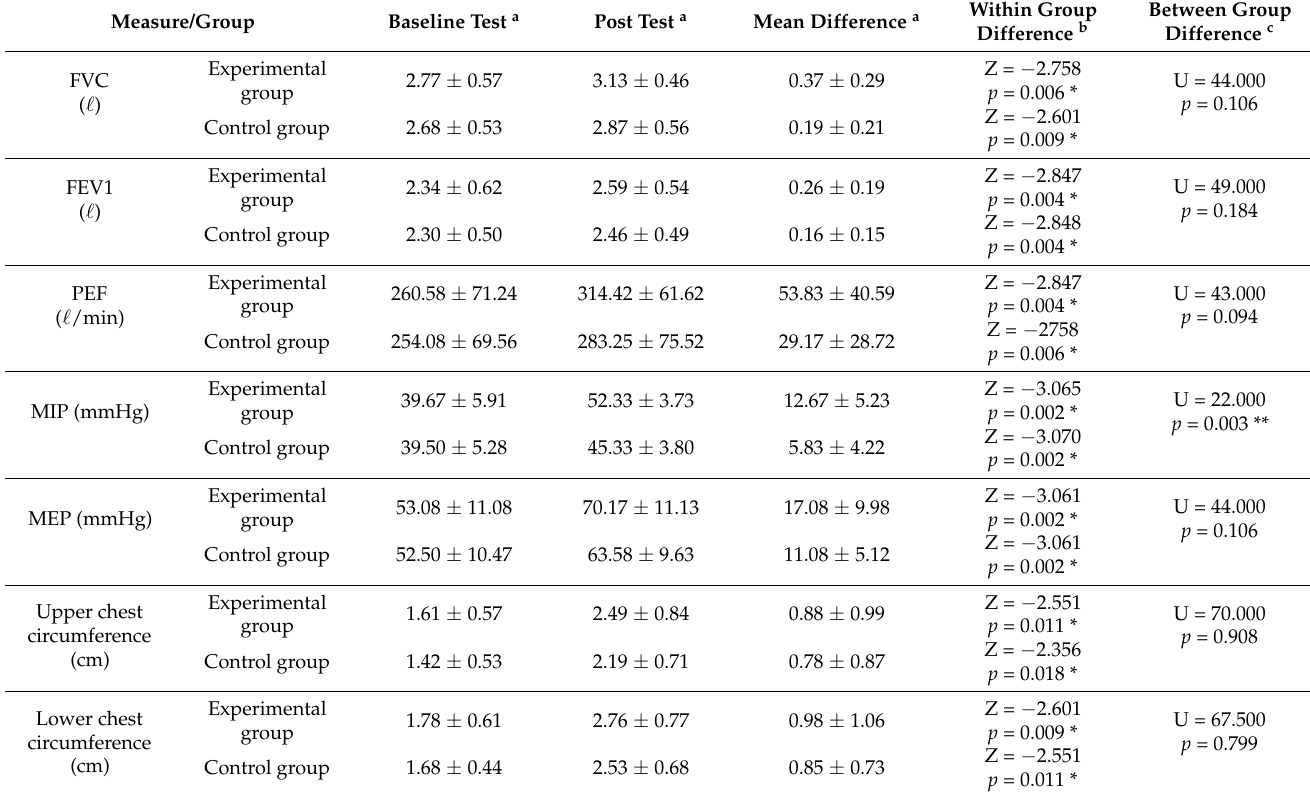
Table 3. Changes of respiratory function on two intervention